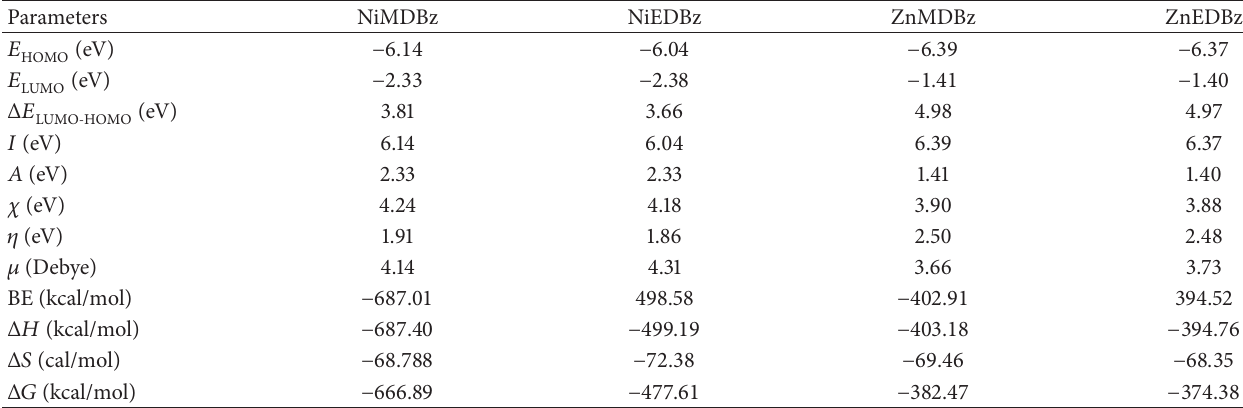
Table 2: Some electronic and thermodynamic parameters of NiMDBz, NiEDBz, ZnMDBz, and ZnEDBz b . Parameters 𝐸 HOMO